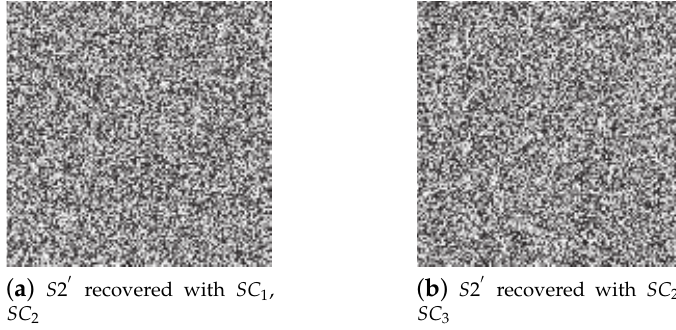
Figure 7. Experimental results of the proposed ( 3,4 ) threshold SIS with dealer-participatory and non-dealer-participatory mutual shadow authentication capabilities, when less than k ( k = 3) shadows were collected. ( a ) S 2 (cid:48) recovered with SC 1 , SC 2 ; ( b ) S 2 (cid:48) recovered with SC 2 , SC 3